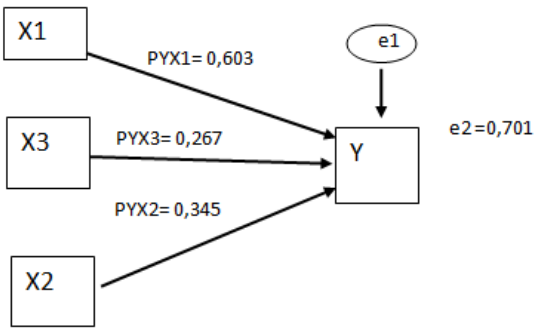
Figure 3. Testing model of direct effect of X1, X2, and X3 on